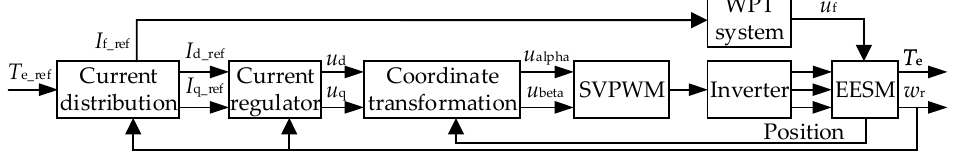
Figure 6. The rotor field oriented control (RFOC) system of EESM.